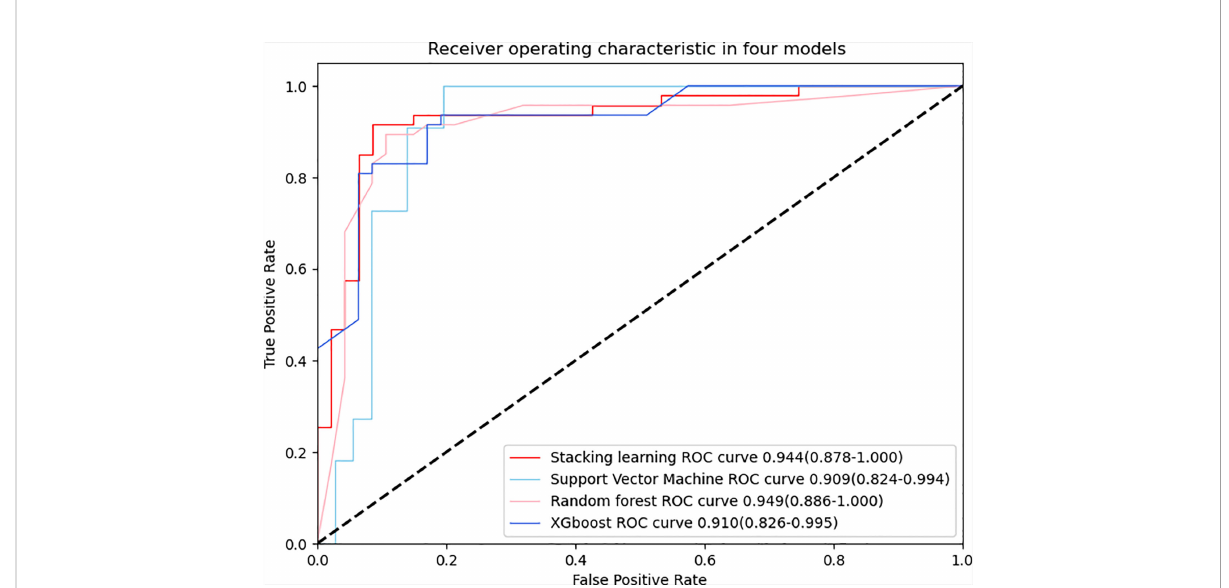
FIGURE 4 ROC curve is adopted to evaluate the diagnostic ef fi cacy in four models. All four models have similar and excellent performance and detailed AUC values are respectively displayed in the graph, indicating the robust performance of quantitative features after LASSO selection.